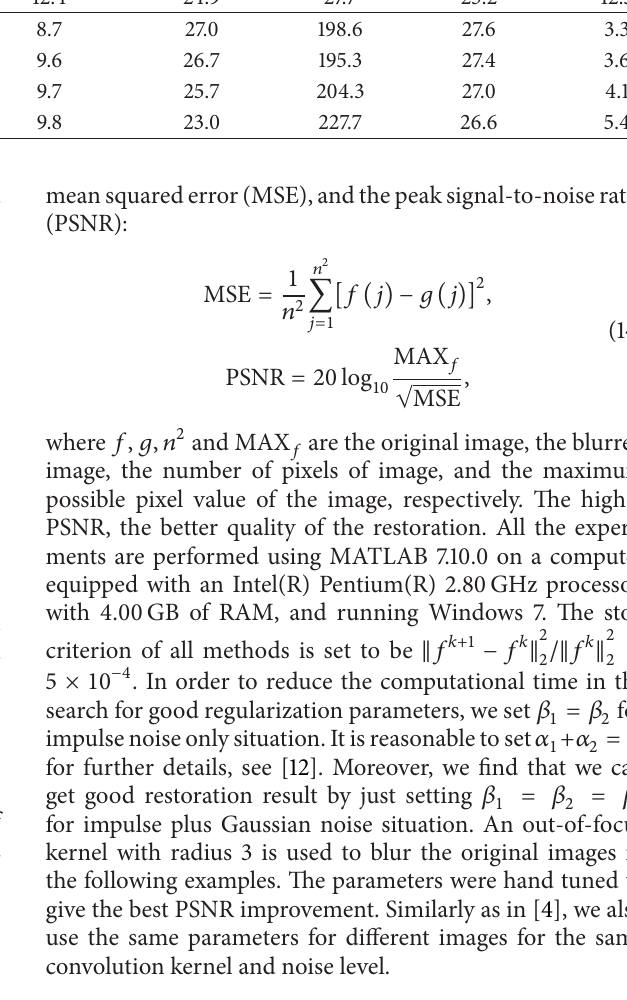
Table 2: The PSNR (dB) and computing time (seconds) for the restoration results by MNID-ADMM, Cai-TP, and HADMM for blurred Lena contaminated by Gaussian noise ( 𝜎 = 5) plus impulse noise. The blurring kernel is the out-of-focus kernel of radius 3. MNID-ADMM Cai-TP HADMM Type Level PSNR Time PSNR Time PSNR Time 30% 27.7 50% Gaussian + salt and pepper